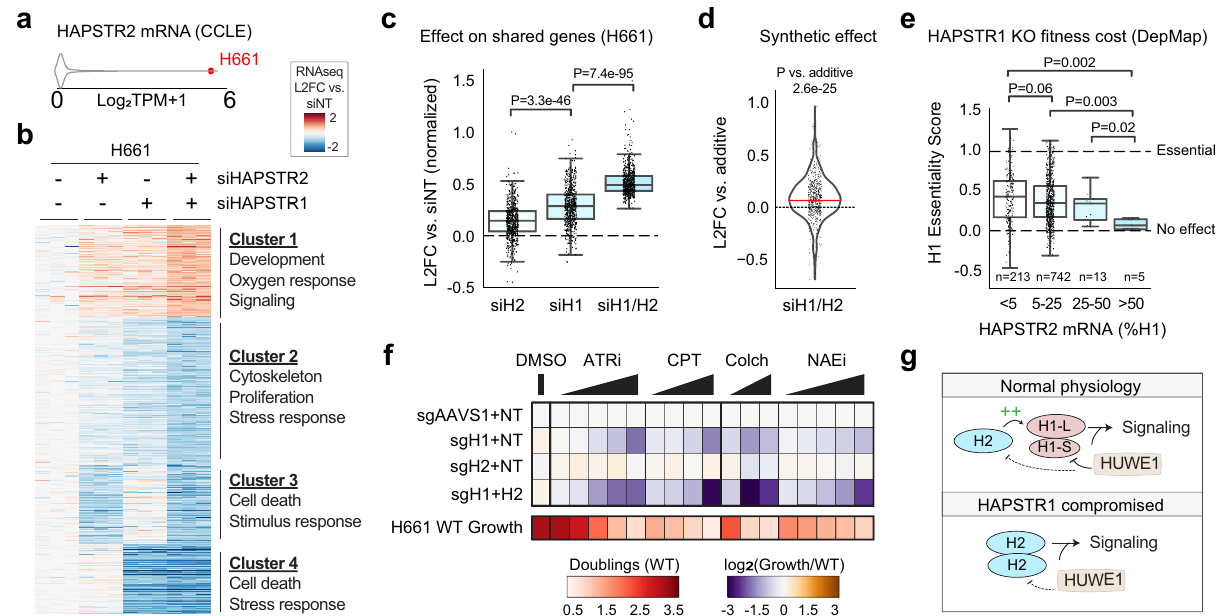
Fig. 6 | HAPSTR2 safeguards resilience. a Plot illustrating relatively high expres- sion ofendogenous HAPSTR2 in H661 cells. b RNA-sequencing ofHAPSTRparalog depletion in isolation or together using siRNA; all differentially expressed genes in the double knockdown condition are shown. See Supplementary Data 3. N =3. c Magnitude of effects on gene expression for the indicated perturbation, where eachpointisagene( n =589)fromcluster1or2.Notethatthefoldchangeforgenes in Cluster 2 is multiplied by -1 to include both up- and down-regulated genes. Mann – Whitney U ,two-tailed .d Theobservedgeneexpressionchangeafterdouble paralog knockdown, relative to the expected effect if siHAPSTR1 and siHAPSTR2 wereactingindependently(andthusaddedtogether).L2FC:Log-2-foldchange.589 genes, one-sample t test. e HAPSTR1 knockout (KO) via CRISPR-Cas9 markedly reduces fi tnessinmostcancercelllines,butlesssoincelllinesexpressingrelatively